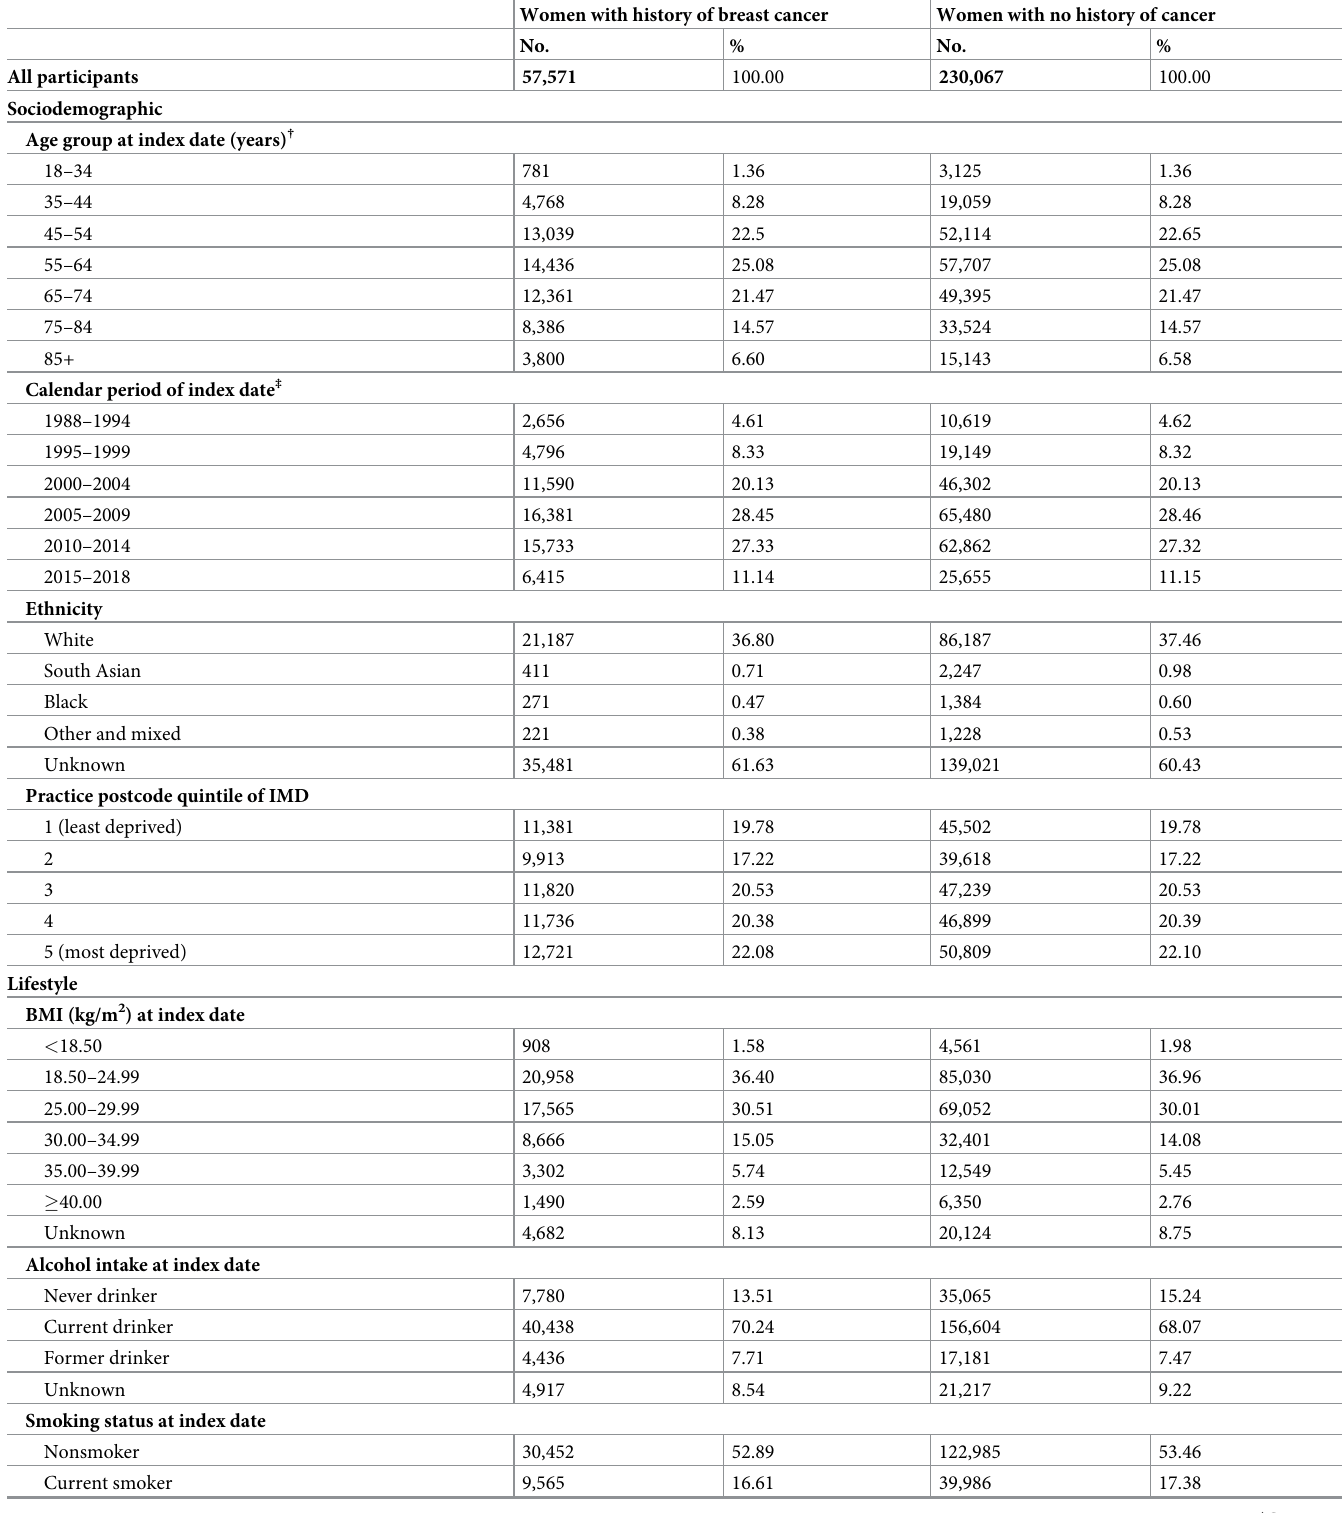
Table 1. Characteristics of the study participants (1988–2018) � . Women with history of breast cancer Women with no history of cancer No. % No. % 57,571 100.00 230,067